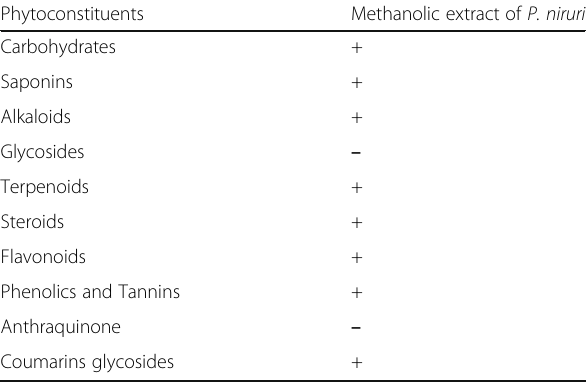
Table 1 Preliminary phytochemical analysis of P. niruri leaves extract